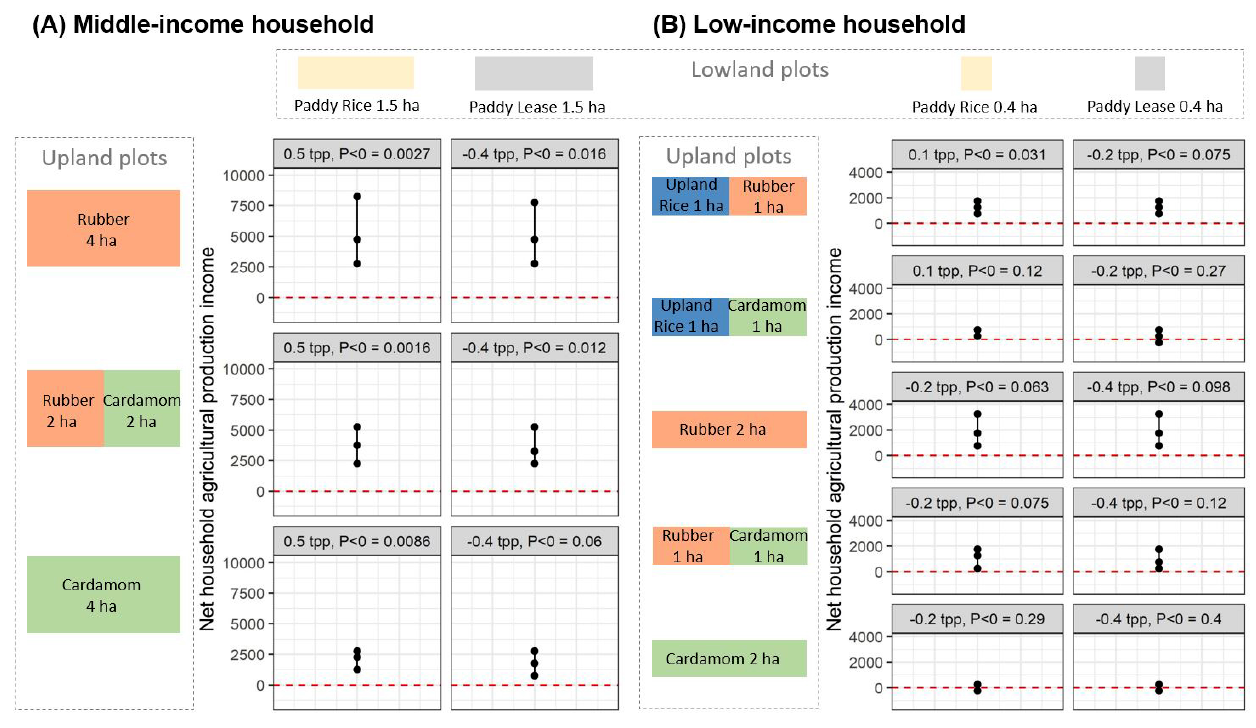
Fig. 6 . Twenty-five percent and 75% income quantiles (lower and upper points) and median income (central point) for different land use configurations for a (A) middle-income household and (B) low-income household representative of both case study areas. Where only two points are present, they represent the 25% and 75% income quantiles. The headings indicate household net rice production per person: positive values indicate excess rice production, and negative values indicate net rice purchase. The probability of falling under zero net agricultural production income (P < 0) is indicated.